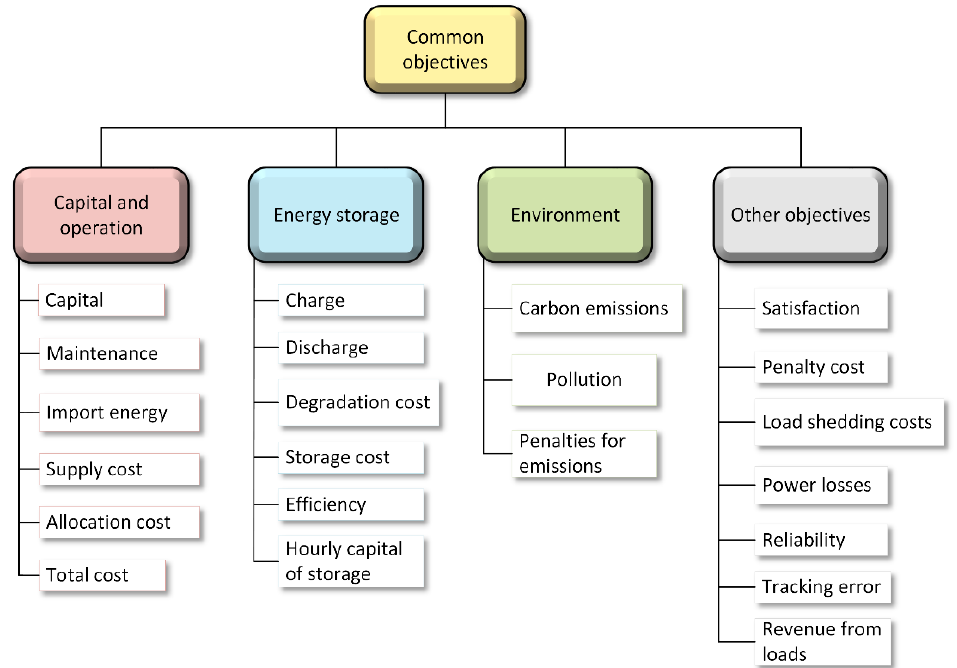
Figure 5. Different types of objectives for HPVBS.